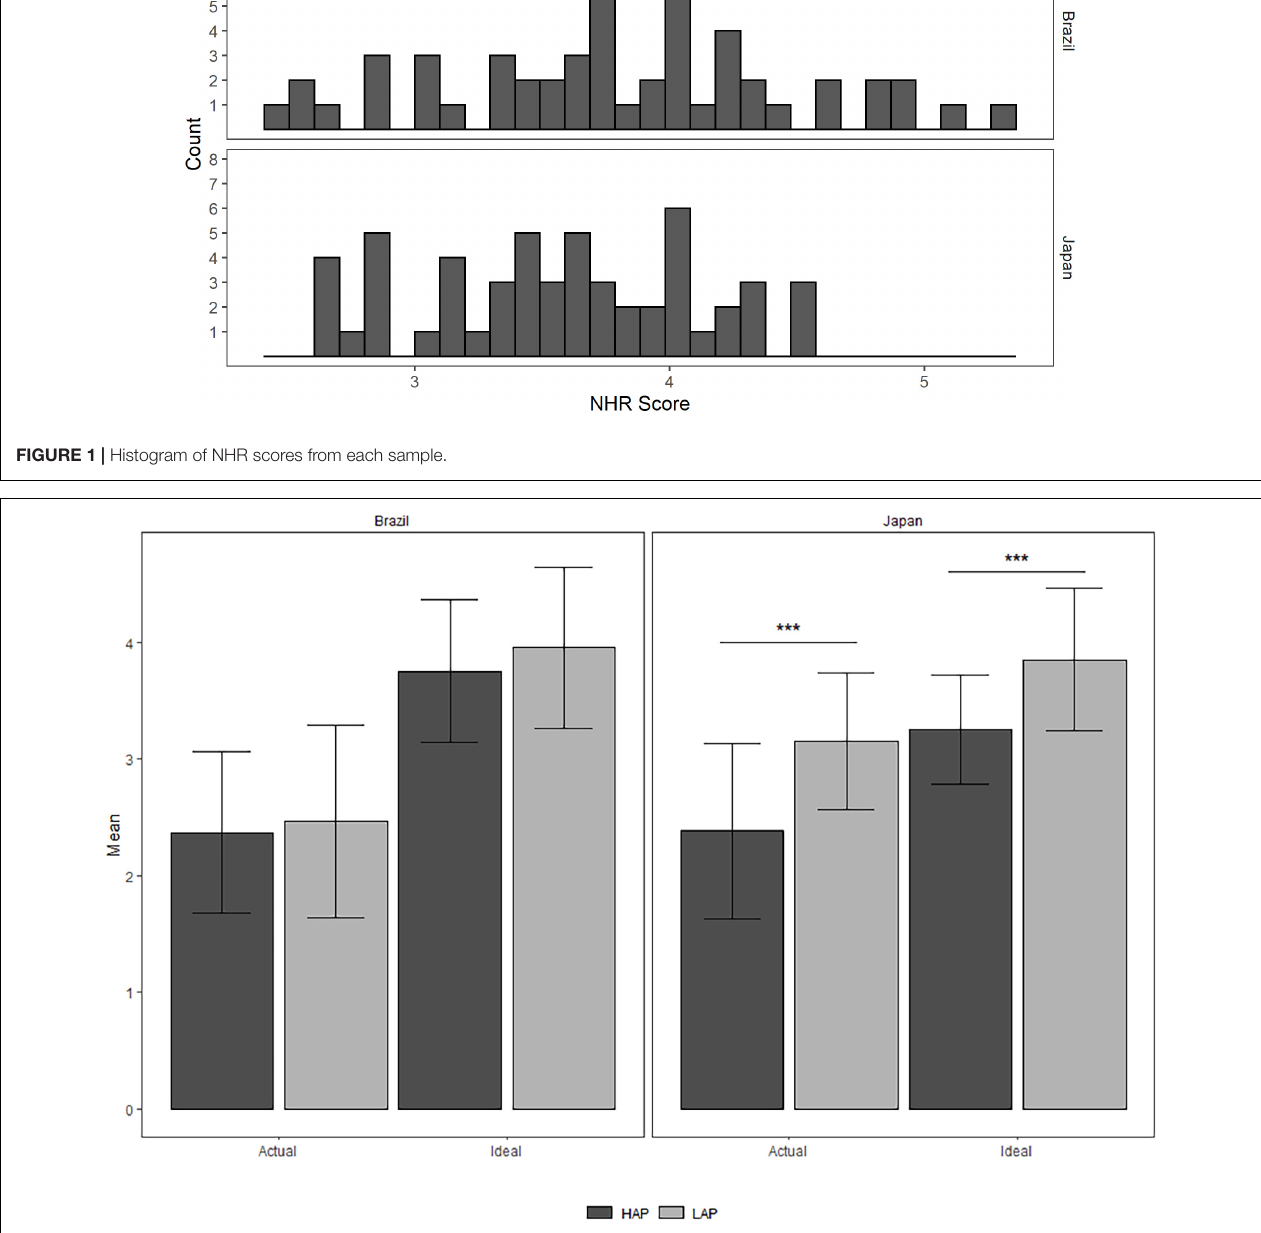
FIGURE 2 | Comparison of actual and ideal HAP and LAP between Brazil and Japan (error bars represent standard deviation of the mean). *** p < 0.001.